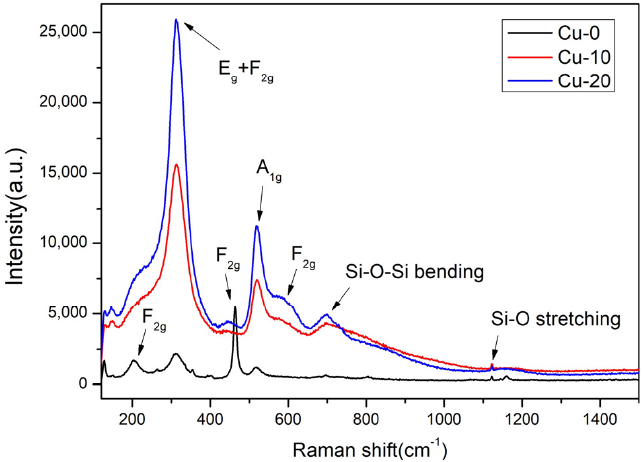
Figure 4. Raman spectra of the Cu-0, Cu-10, and Cu-20 samples.